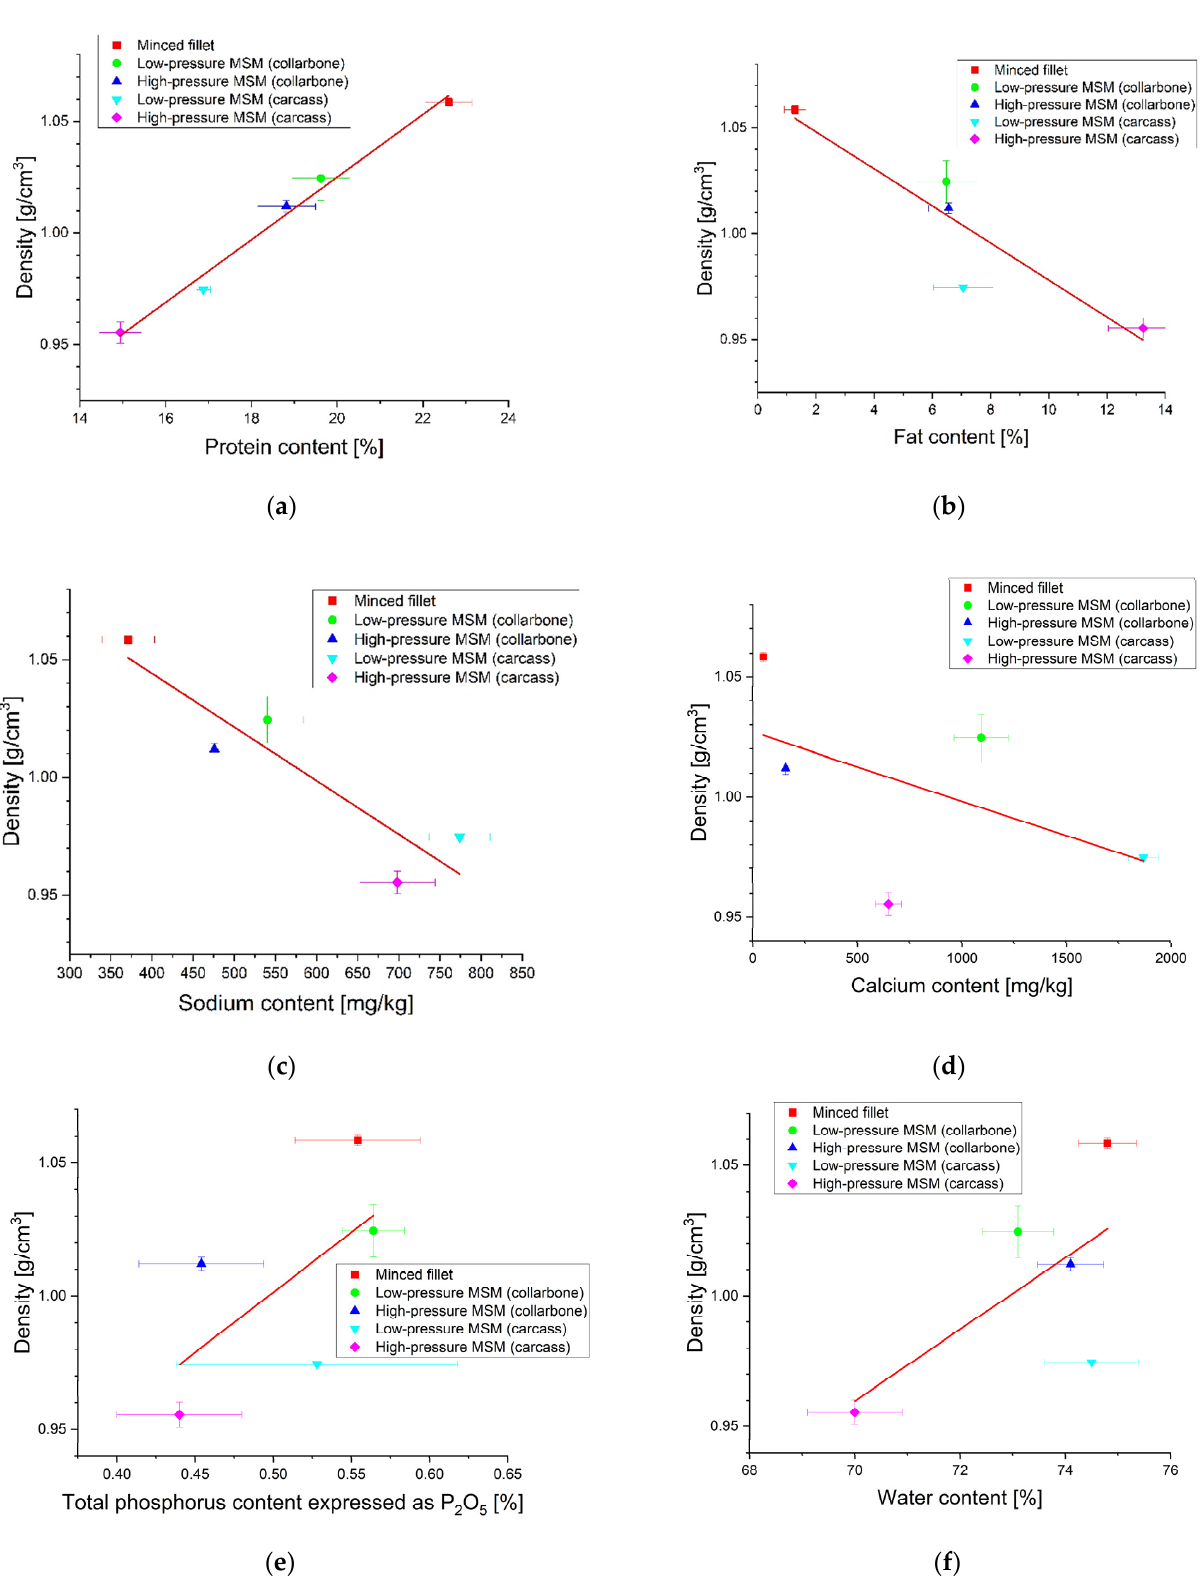
Figure 2. Linear regression curves relating measured density 𝜌 with the content of ( a ) protein, ( b ) fat, ( c ) sodium, ( d ) calcium, ( e ) phosphorus and ( f ) water.